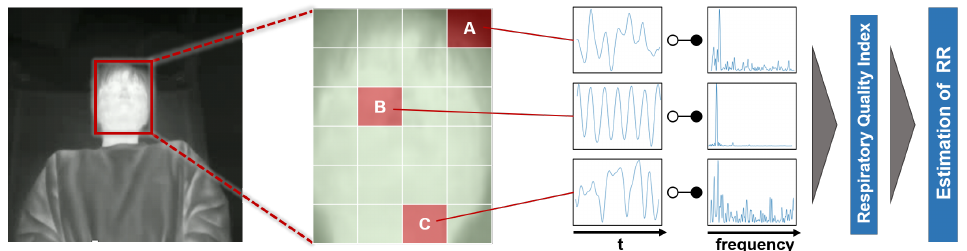
Figure 1. Overview of proposed method: Firstly, a rectangular region of a face is detected by YOLO v3 [11]. The detected face region is divided into 4 × 6 subregions. Signal intensity is extracted from each subregion, and signal processing is applied. By calculating the respiratory likelihood of each segmented region using the newly proposed index “RQI (Respiratory Quality Index)”, the respiratory-related region is automatically selected and RR is